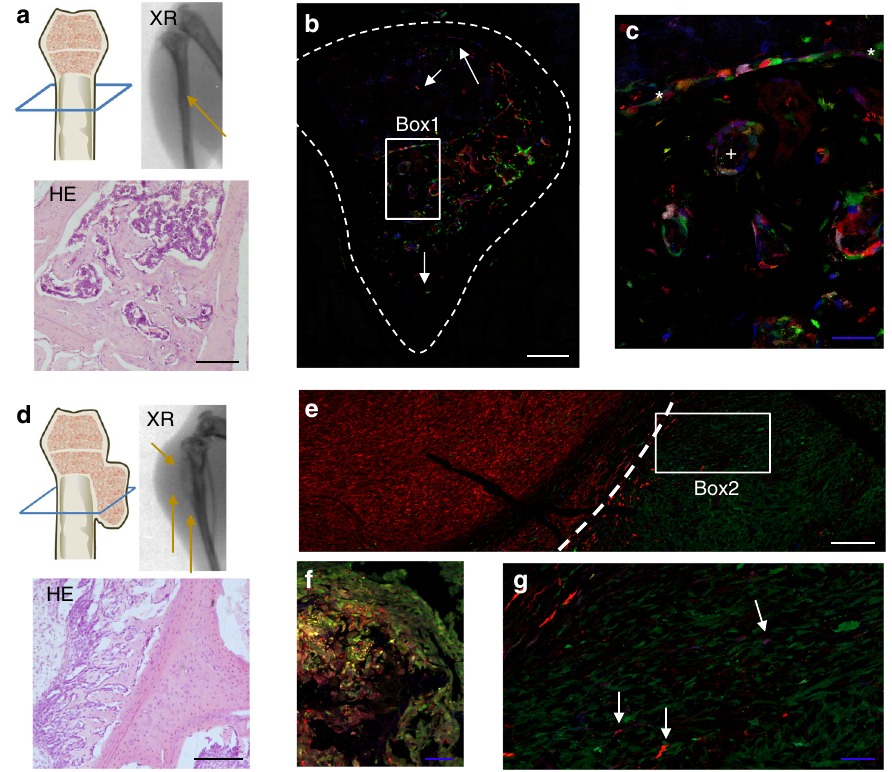
Fig. 4 Orthotopically implanted RAINBONE cells generate polyclonal tumours. a Tumour developing in the medullar space (orange arrow). Blue section indicates the visual plane for haematoxylin/eosin staining (HE) and confocal images. XR X-ray imaging. b Representative image of RAINBONE cells located in the endosteal space, at perivascular locations, and in compact bone (white arrows). c Detail view of picture B (Box 1) showing osteoblastic rimming (*) and malignant trabecular bone ( + ). d Osteolytic tumour overgrowing as a soft tissue mass at 50 days presented strong periosteal reaction and a Codman triangle (orange arrows). e Representative image of a large bi-clonal area growing on the outer surface of bone; two different dominant clones are developing in opposition (white line indicates the border limits). f Detailed view of cartilage plate in fi ltration and destruction. g Picture detail (Box 2) of the clonal growth in the surrounding of musculoskeletal tissue, with low-frequency clones (white arrow) among larger monoclonal areas. White and black bars = 200 µ m; blue bars = 50 µ m; n =